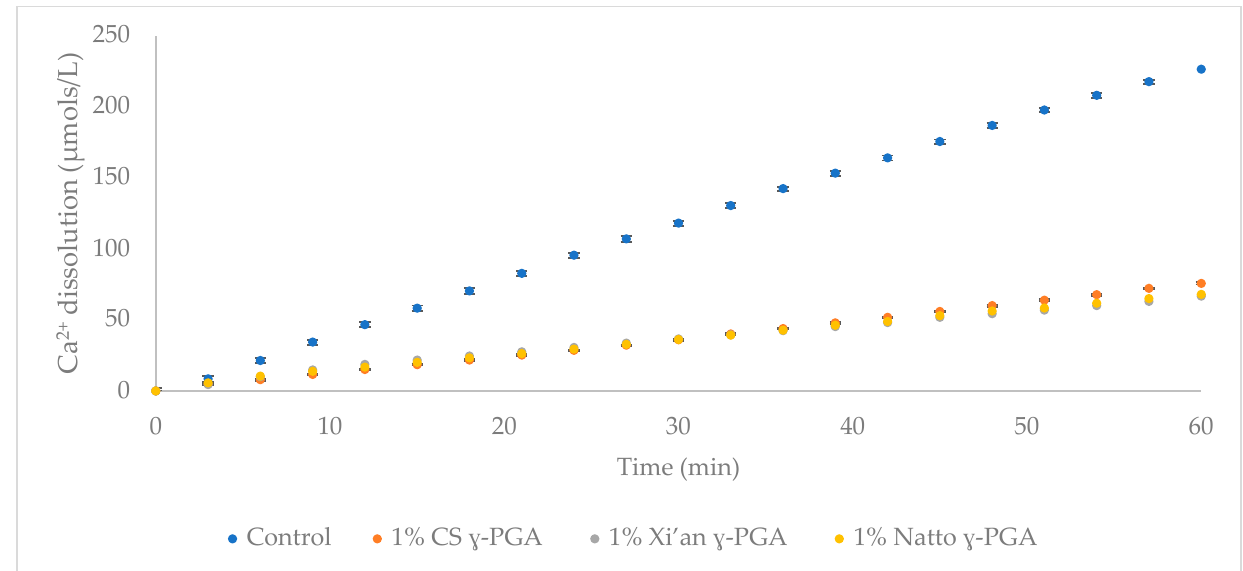
Figure 5. Linear regression analysis of the ISE pilot study result showing the Ca 2+ activity from HAp disc (20% porous) protected by different commercial γ -PGA at 1% (w/v) with disc immersion for 2 min. n = 3. Error bars indicate standard error values.